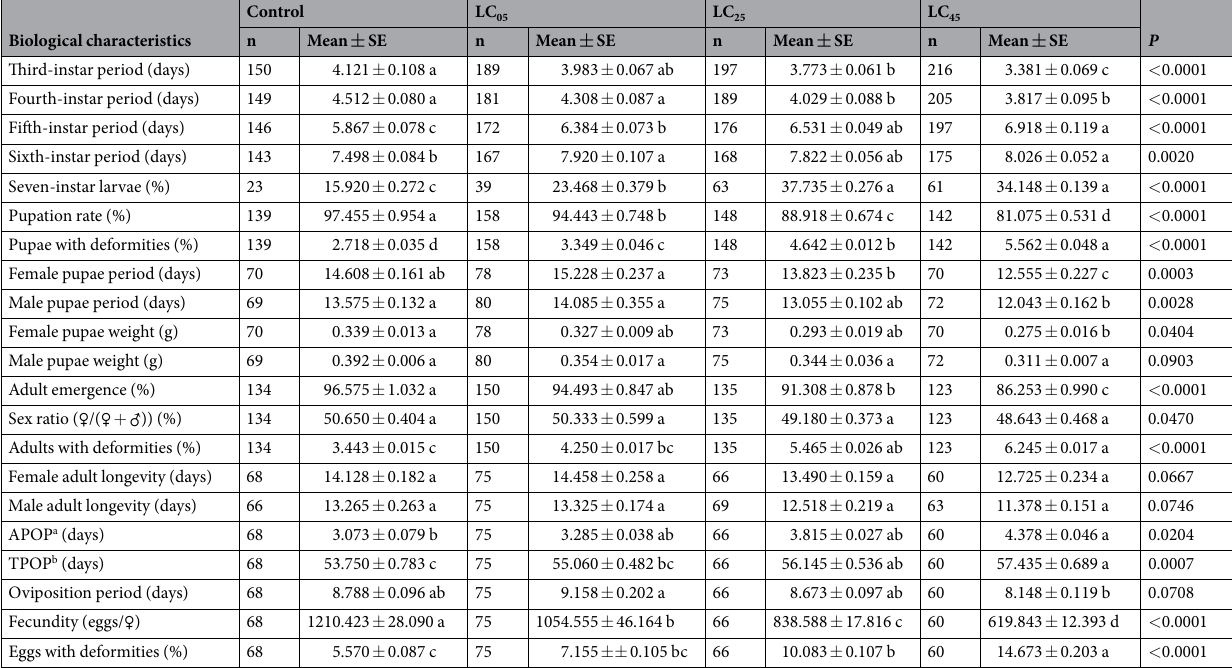
Table 2. Effects of chlorantraniliprole treatment on growth and development (mean ± SE) of A. ipsilon 3rd- instar larvae. a Adult preoviposition period. b Total preoviposition period. Means marked with different lowercase letters in the same row are significantly different ( P < 0.05).